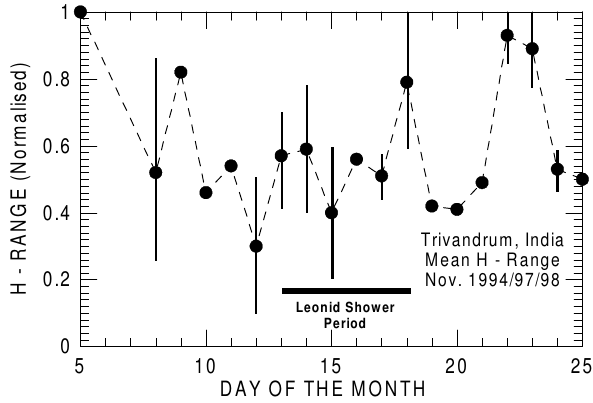
Fig. 5. Height profile of the Cowling conductivity under conditions of maximum electrojet currents on 7 July 1966 at 13:45 LT with and without an assumed charged dust layer.